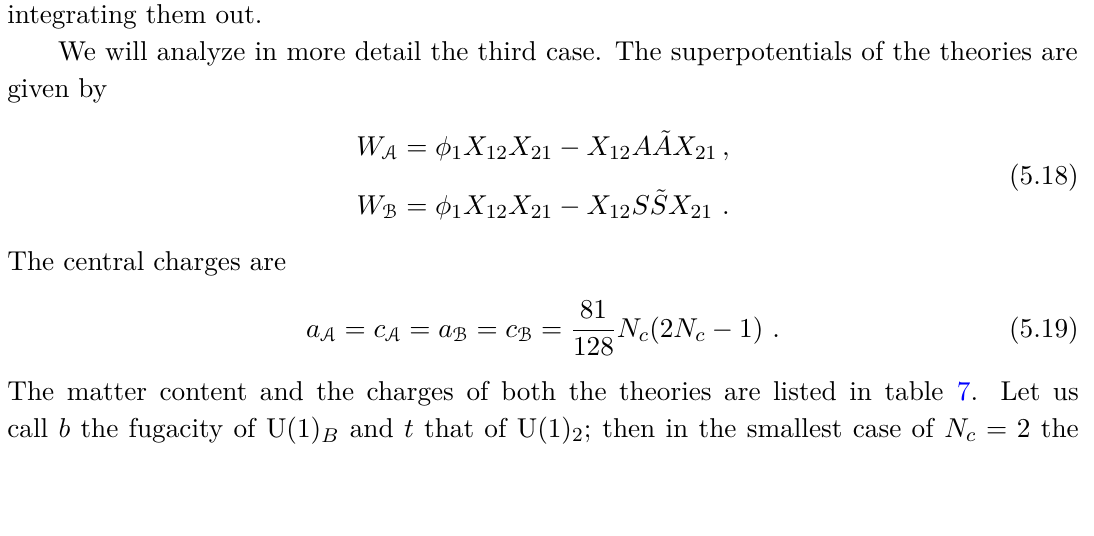
tensor fields have R-charge 1 , i and integrate them out, yielding the 2 i φ i